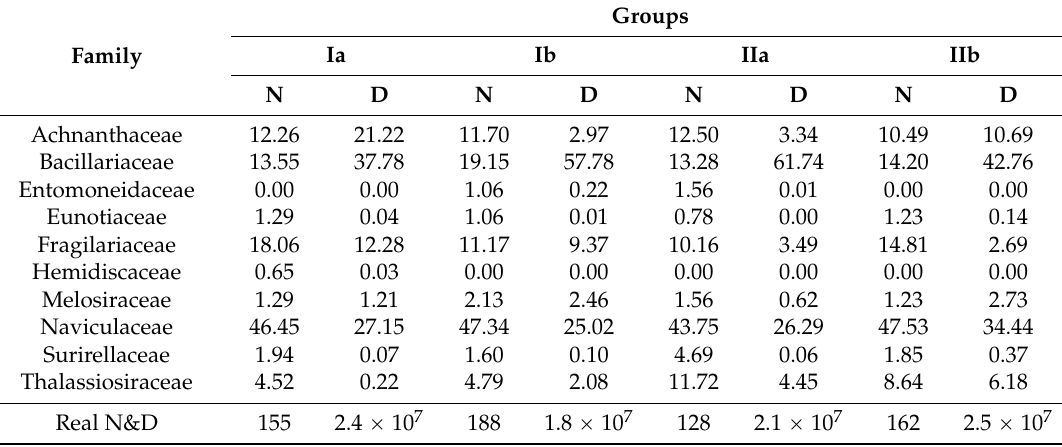
Table 2. Species (N, %) and cell density (D, %) of epilithic diatom communities distributed in Korean estuaries between 2012 and 2014 at the family level. The estuaries were divided into four groups by cluster analysis based on diatom